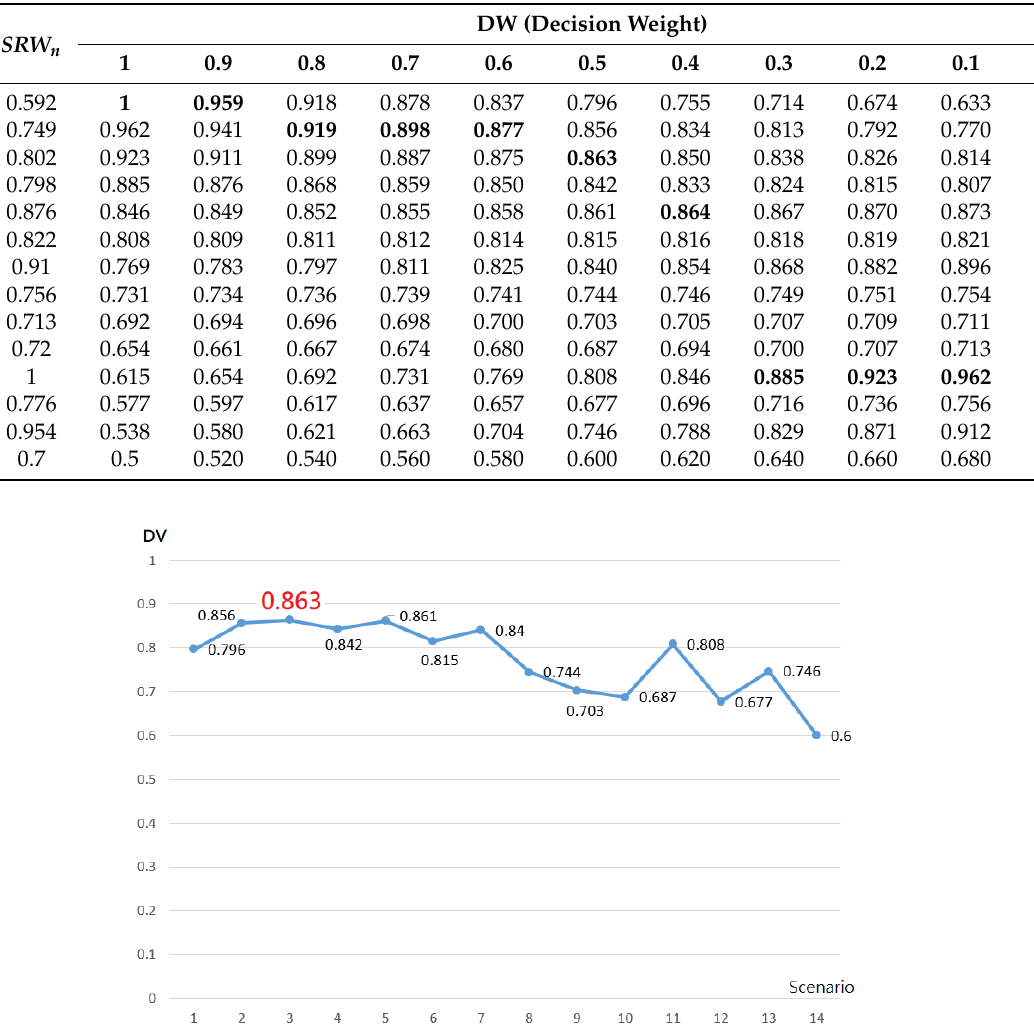
Table 4. Decision values (DV) of scheduling scenarios.